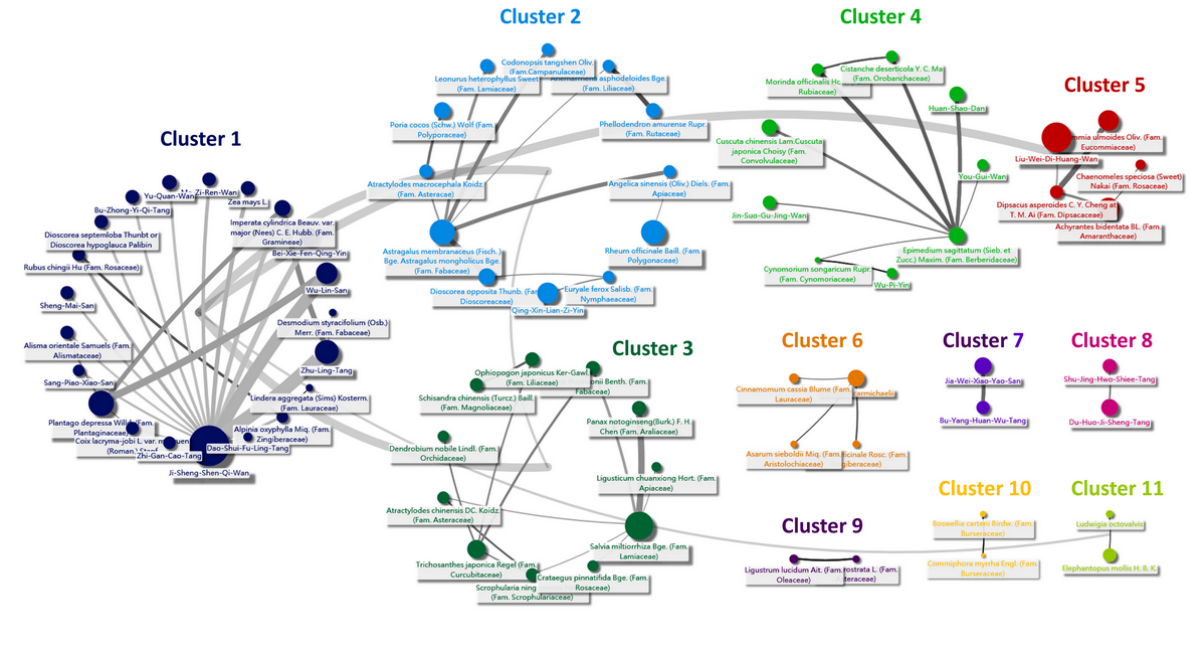
P value99% CIaHR a Deaths, nSubjects, nVariable